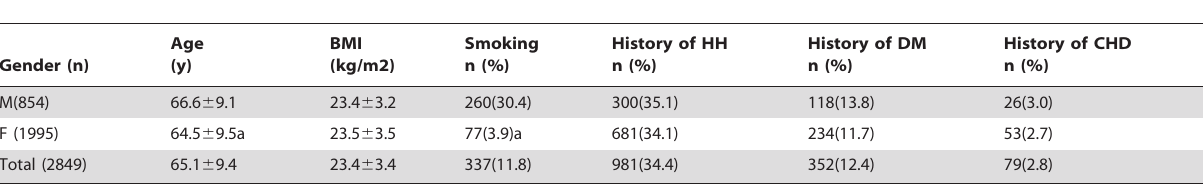
Table 1. Comparison of general information of two gender groups.